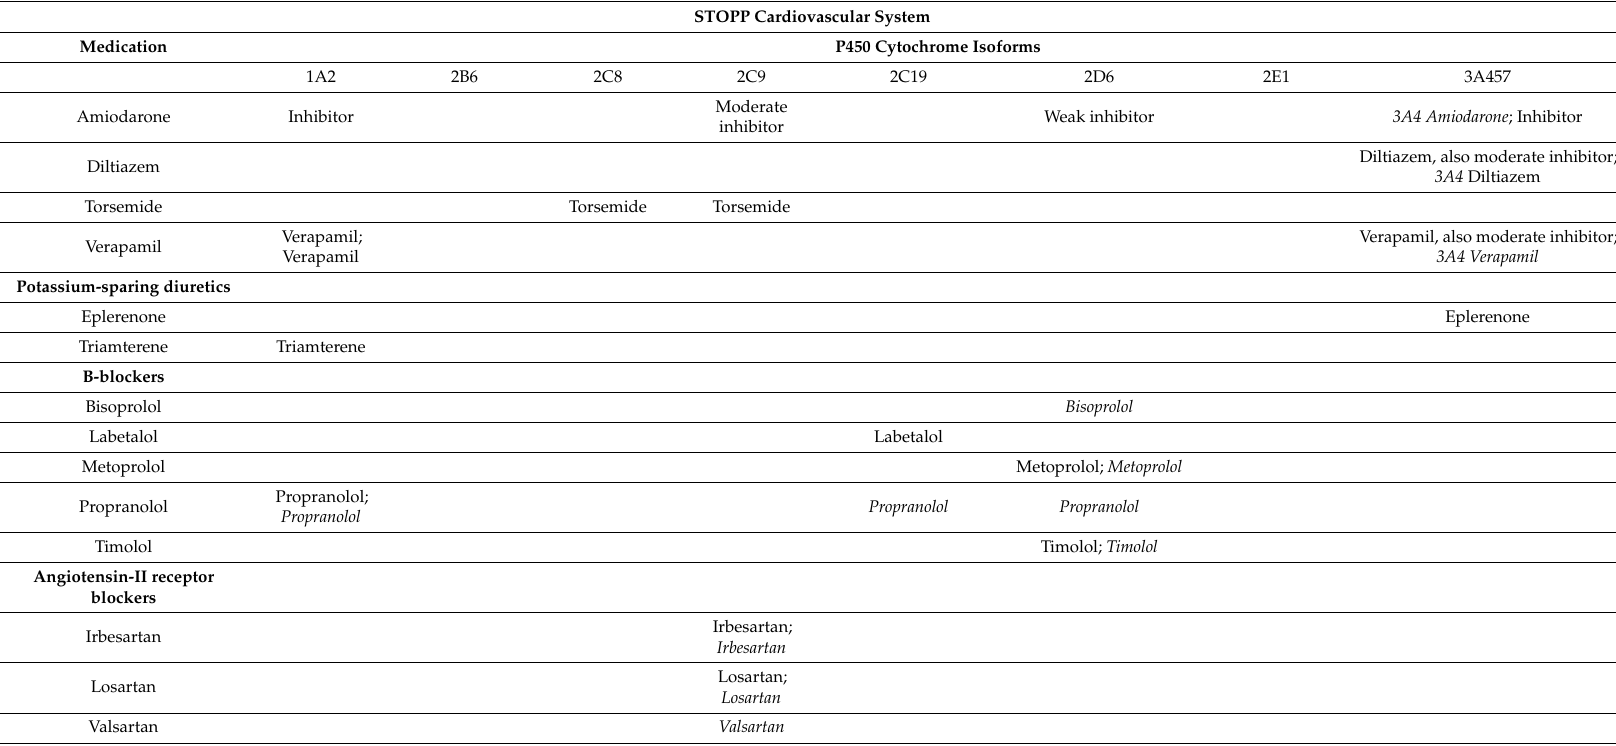
Table 4. Screening Tool of Older People’s Prescriptions (STOPP) 2015 criteria for Potentially Inappropriate Medication Use in older adults for which the P450 cytochrome isoform is known. Sources: Bold print = DrugBank [25]; Regular print = Flockhart Table [26]; Italic Print = Rx Files. 12th ed. [27] (p 211). If a medication name is given it indicates it is a substrate metabolized by the P450 cytochromes in the columns listed. If a medication is also an inducer of individual P450 cytochromes the word inducer is used. If a medication is an inhibitor of individual P450 cytochromes the word inhibitor is used. (Inhibitors increase levels of medications metabolized by the same isoform. Inducers decrease levels of medications metabolized by the same isoform). However, if they metabolize a prodrug (e.g., codeine) the result is higher levels of its metabolites (e.g.,